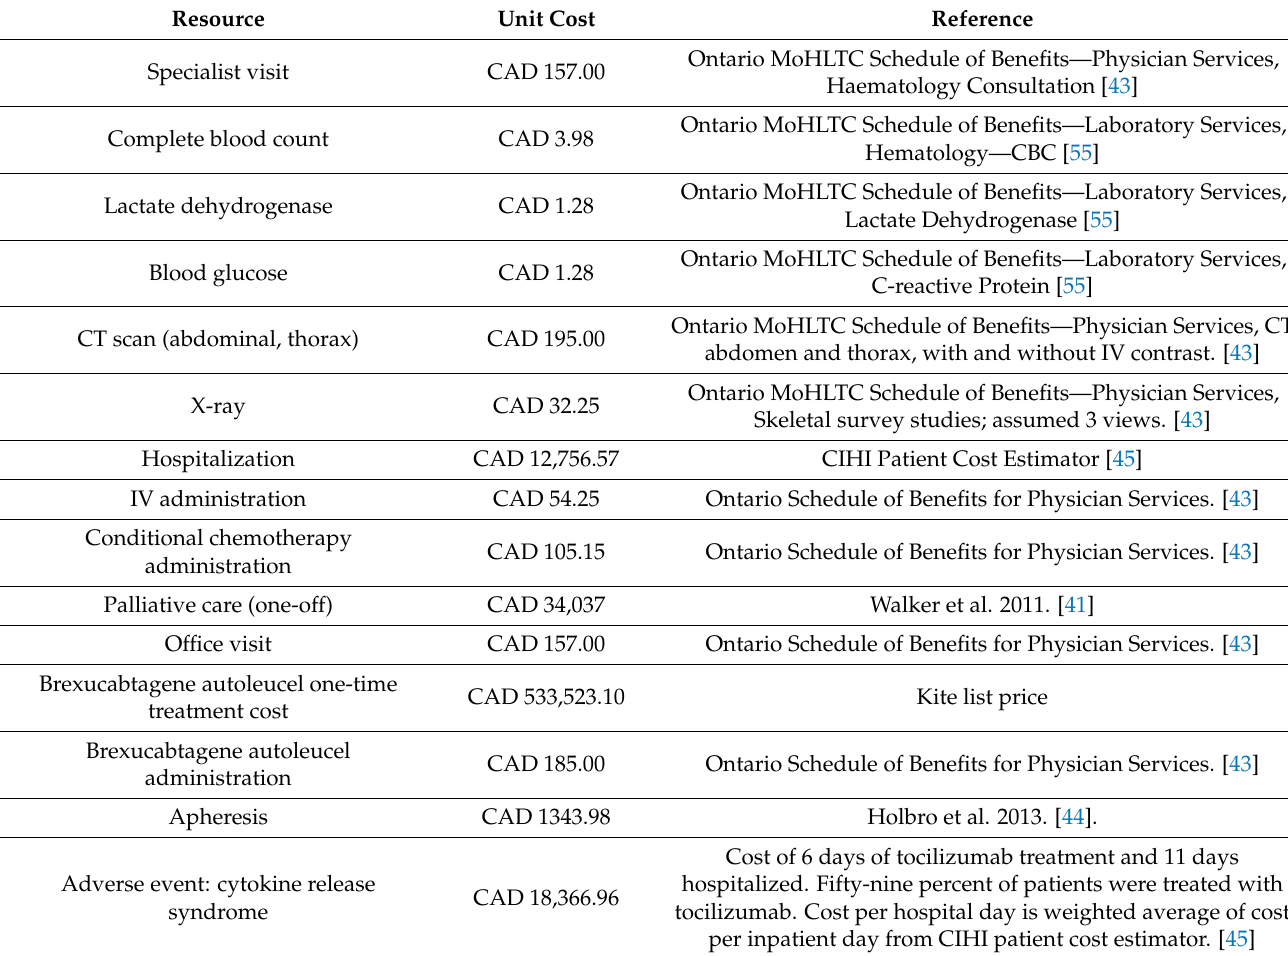
Table A2. Extended cost table, including unit cost per medical